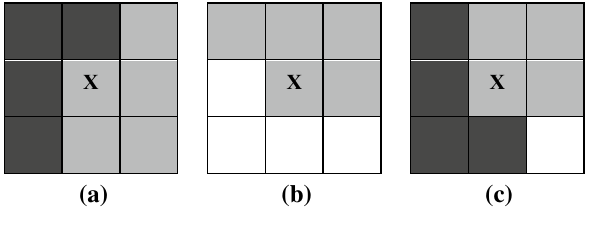
Table 1 Summary of the employed